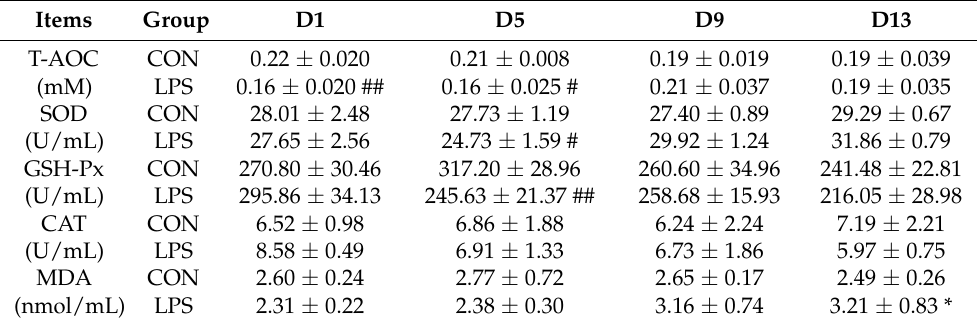
Table 2. Effects of LPS induction on the serum antioxidant parameters of weaned piglets.